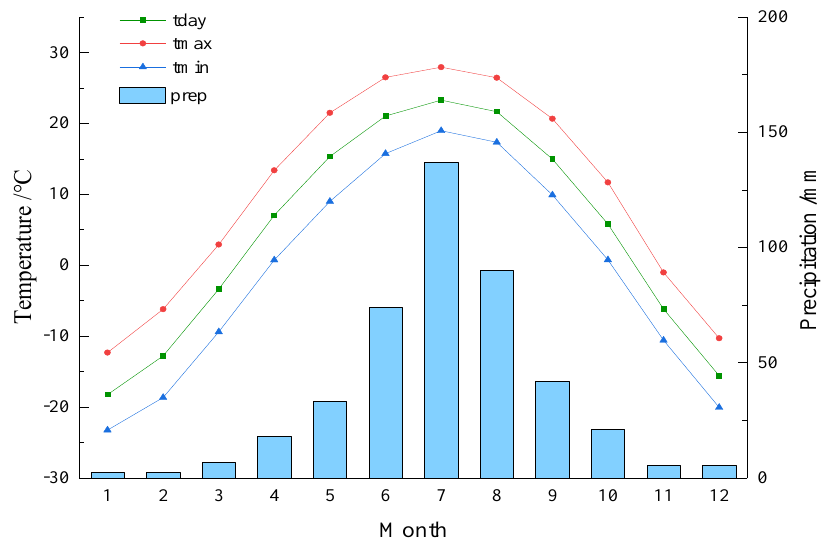
Figure 2. General climatological conditions in the study region.